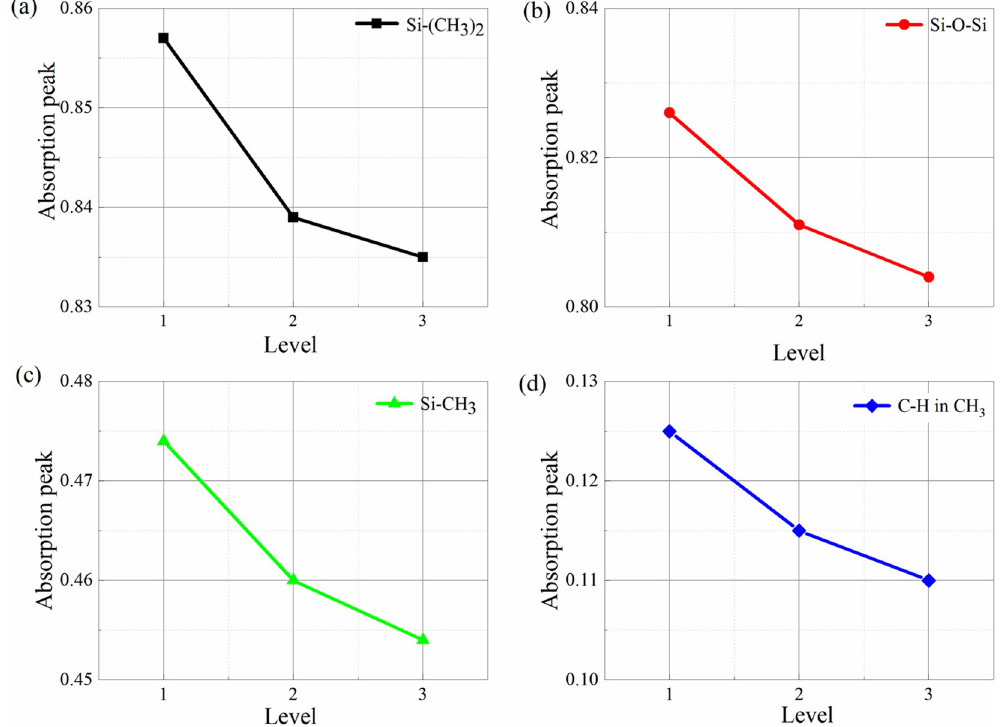
Fig 12. Change of absorption peak in chemical groups with ageing level. (a) absorption peak change graph of Si-(CH 3 ) 2 ; (b) absorption peak change graph of Si-O-Si; (c) absorption peak change graph of Si-CH 3 ; (d) absorption peak change graph of C-H in CH 3